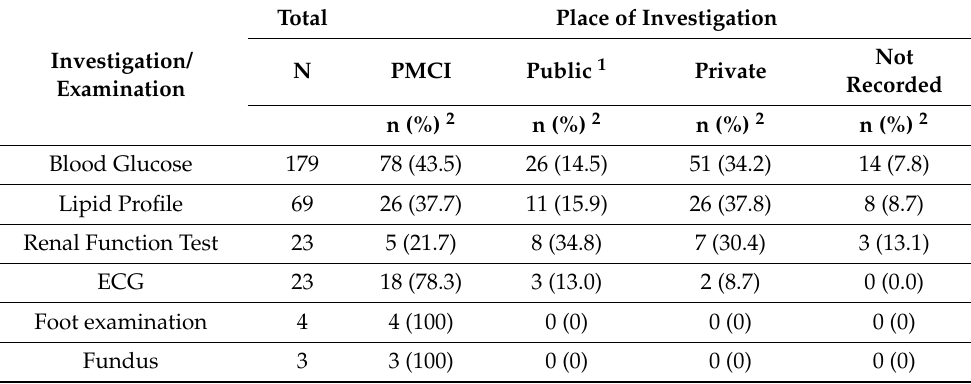
Table 4. Place of investigation/examination among diabetes and/or hypertension patients undergo- ing screening for complications as per guidelines in the nine selected PMCIs supported by PSSP of Sri Lanka,